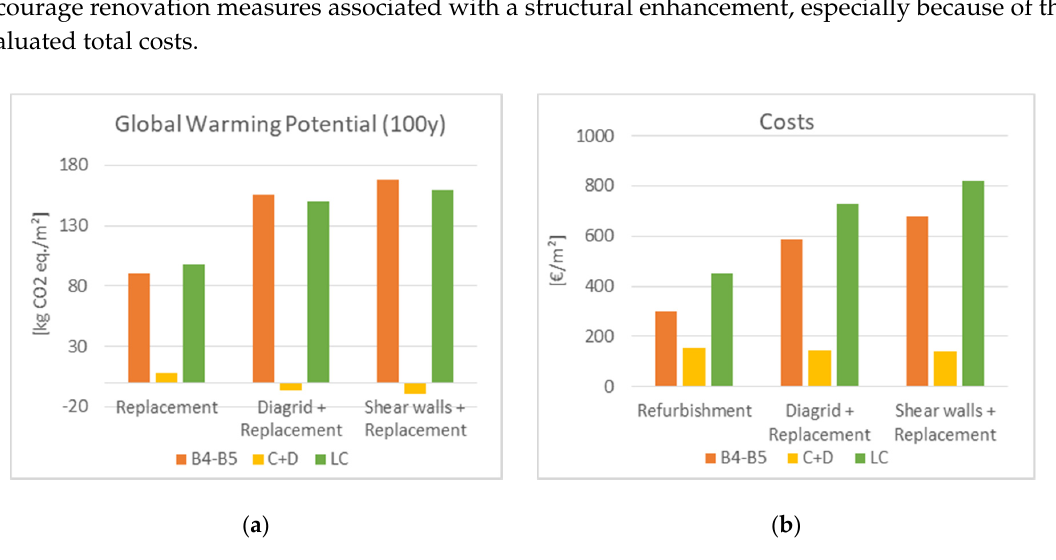
Table 7. Earthquakes characteristics for geographical location of L’Aquila (Source INGV [34]). Note: